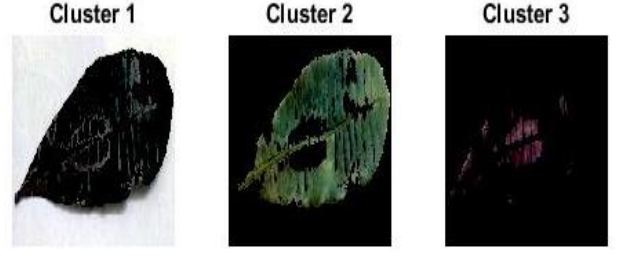
Figure 6. Cluster size 3 and 45 °co-occurrence angle